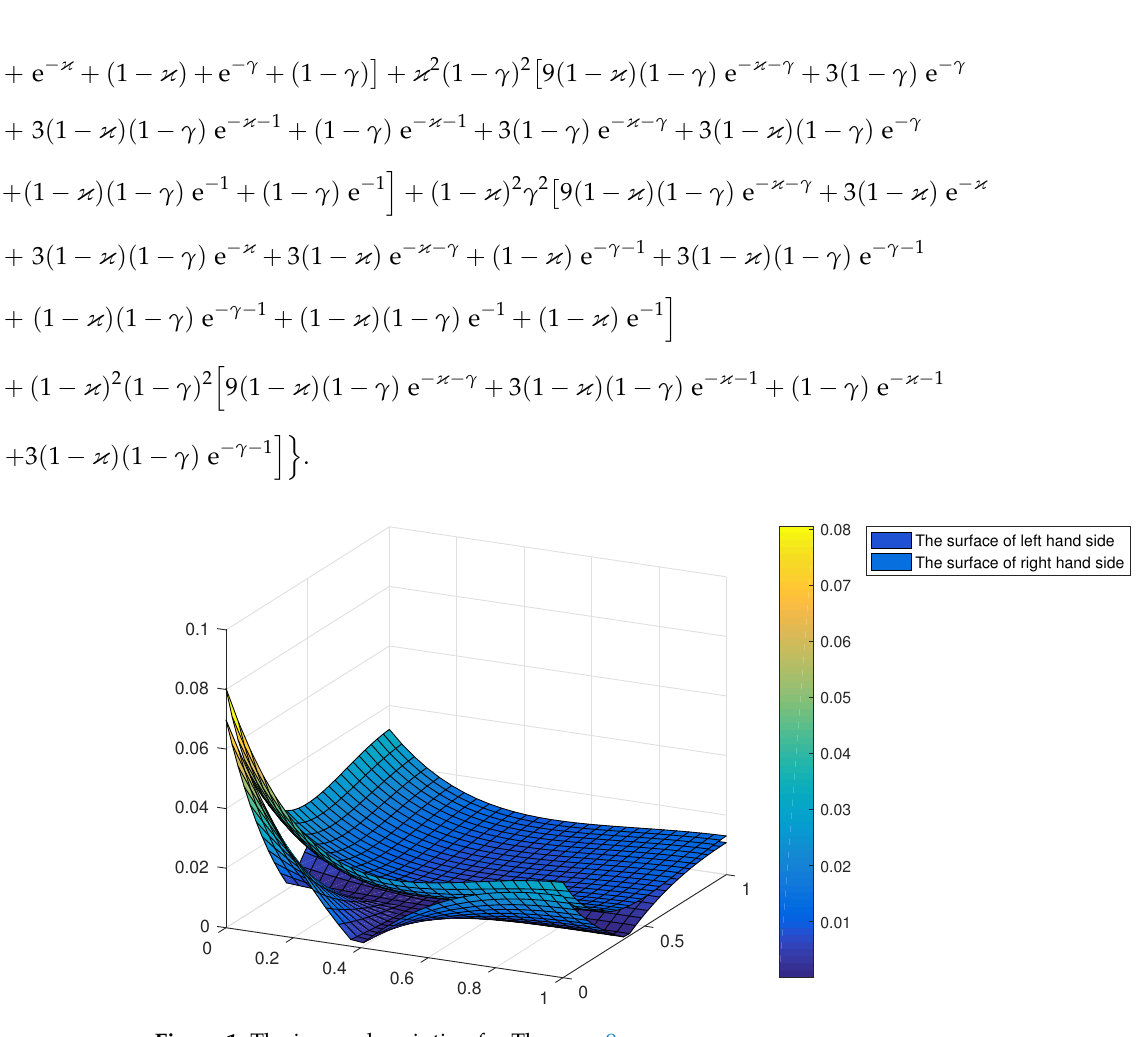
Figure 1. The image description for Theorem